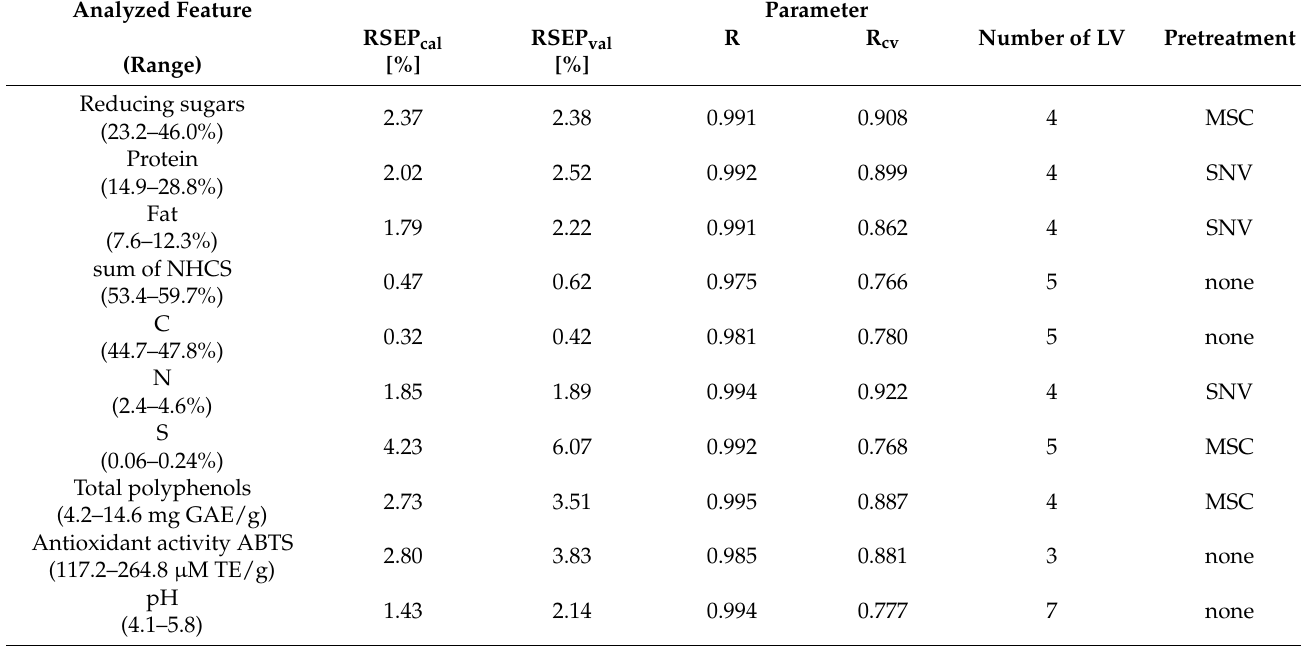
Table 2. Details of the constructed PLS